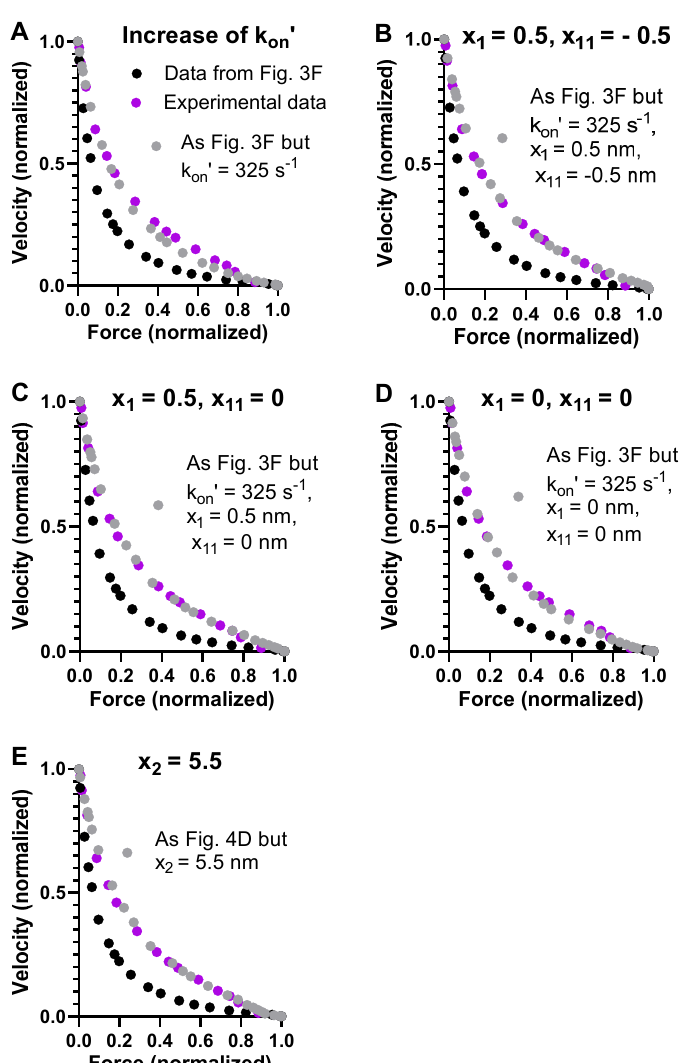
Figure 4. Modeled FV relationships with parameter values in Figure 3F showing effects of increased attachment rate constant and modified values of the parameters x 1 , x 11, and x 2 . ( A ) Effect of increased attachment rate constant k on ’ to 325 s − 1 (grey symbols) compared to data simulated with standard parameter values (with k on ’ = 130 s − 1 ; black-filled symbols) and experimental data used in other figures (purple). ( B ) Grey symbols refer to data modeled with attachment rate constant k on ’ = 325 s − 1 but also with x 1 (0.5 nm) and x 11 ( − 0.5 nm), different from standard parameter values. Black and purple data are the same as in A. ( C ) Grey symbols refer to data modeled with attachment rate constant k on ’ = 325 s − 1 but also with x 1 (0.5 nm) and x 11 (0 nm), different from standard parameter values and from their values in B. Black and purple data are the same as in A. ( D ) Grey symbols refer to data modeled with attachment rate constant k on ’ = 325 s − 1 but also with x 1 (0 nm) and x 11 (0 nm), different from standard parameter values and from their values in B and C. Otherwise, color coding is the same as in A. ( E ) Grey symbols refer to data modeled with same parameter values as in D but with x 2 = − 5.5 nm. Black and purple symbols have same meaning as in ( A ) and in ( B – E